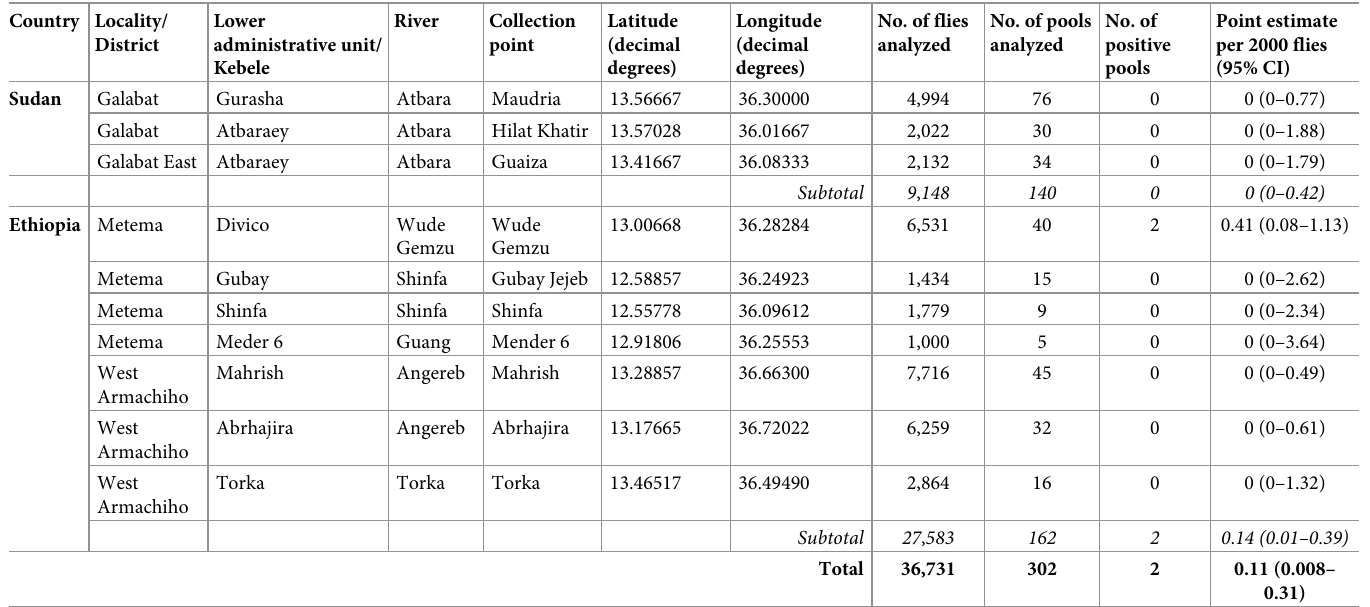
Table 3. PCR Results O . volvulus DNA in Simulium flies collected in Gababat (2015) and Metema/West Armachiho (2017). Country Locality/ District